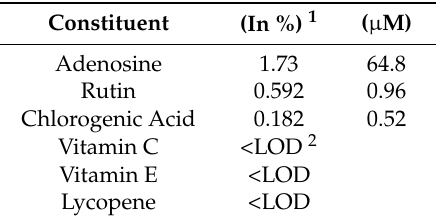
Table 2. Constituents of tomato aqueous extracts (TAE).